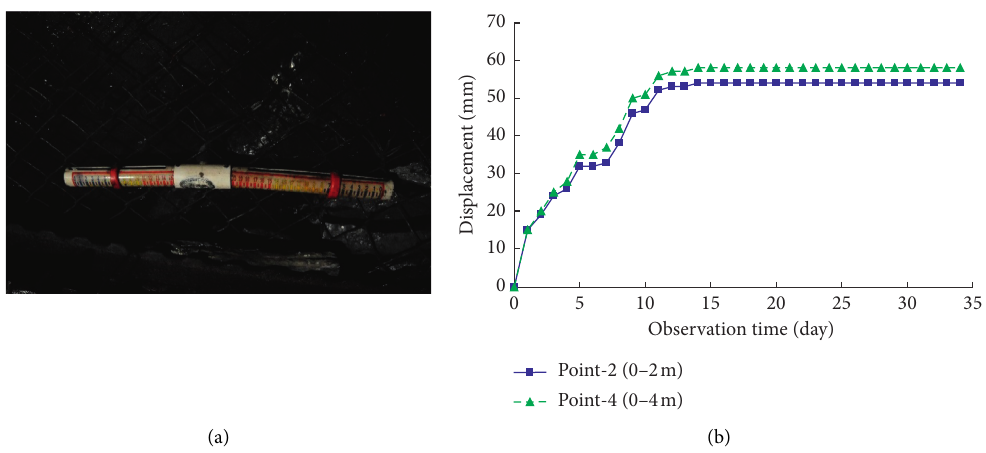
Figure 15: Roof deformation observation. (a) Field monitoring instrument. (b) Roof deformation